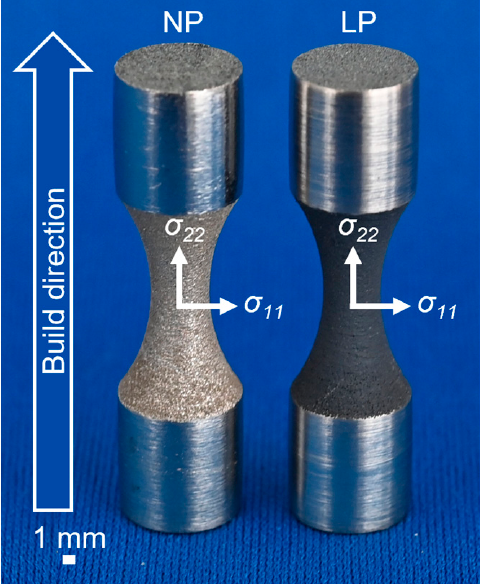
Figure 6. Signal from hydrophone during mechanical surface treatment using pulsed laser.